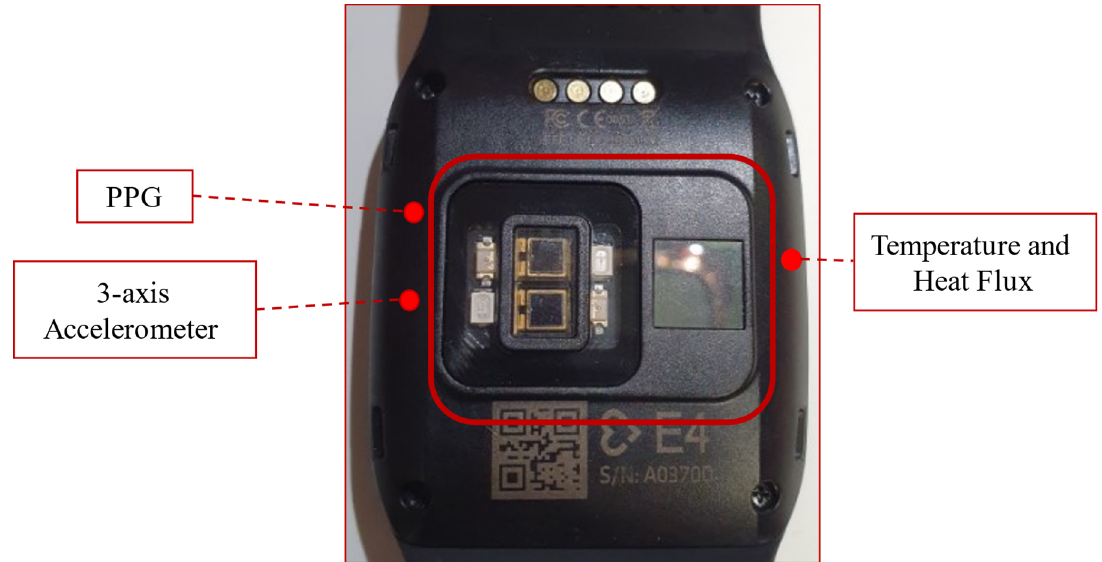
Figure 2. Empatica E4 watch.